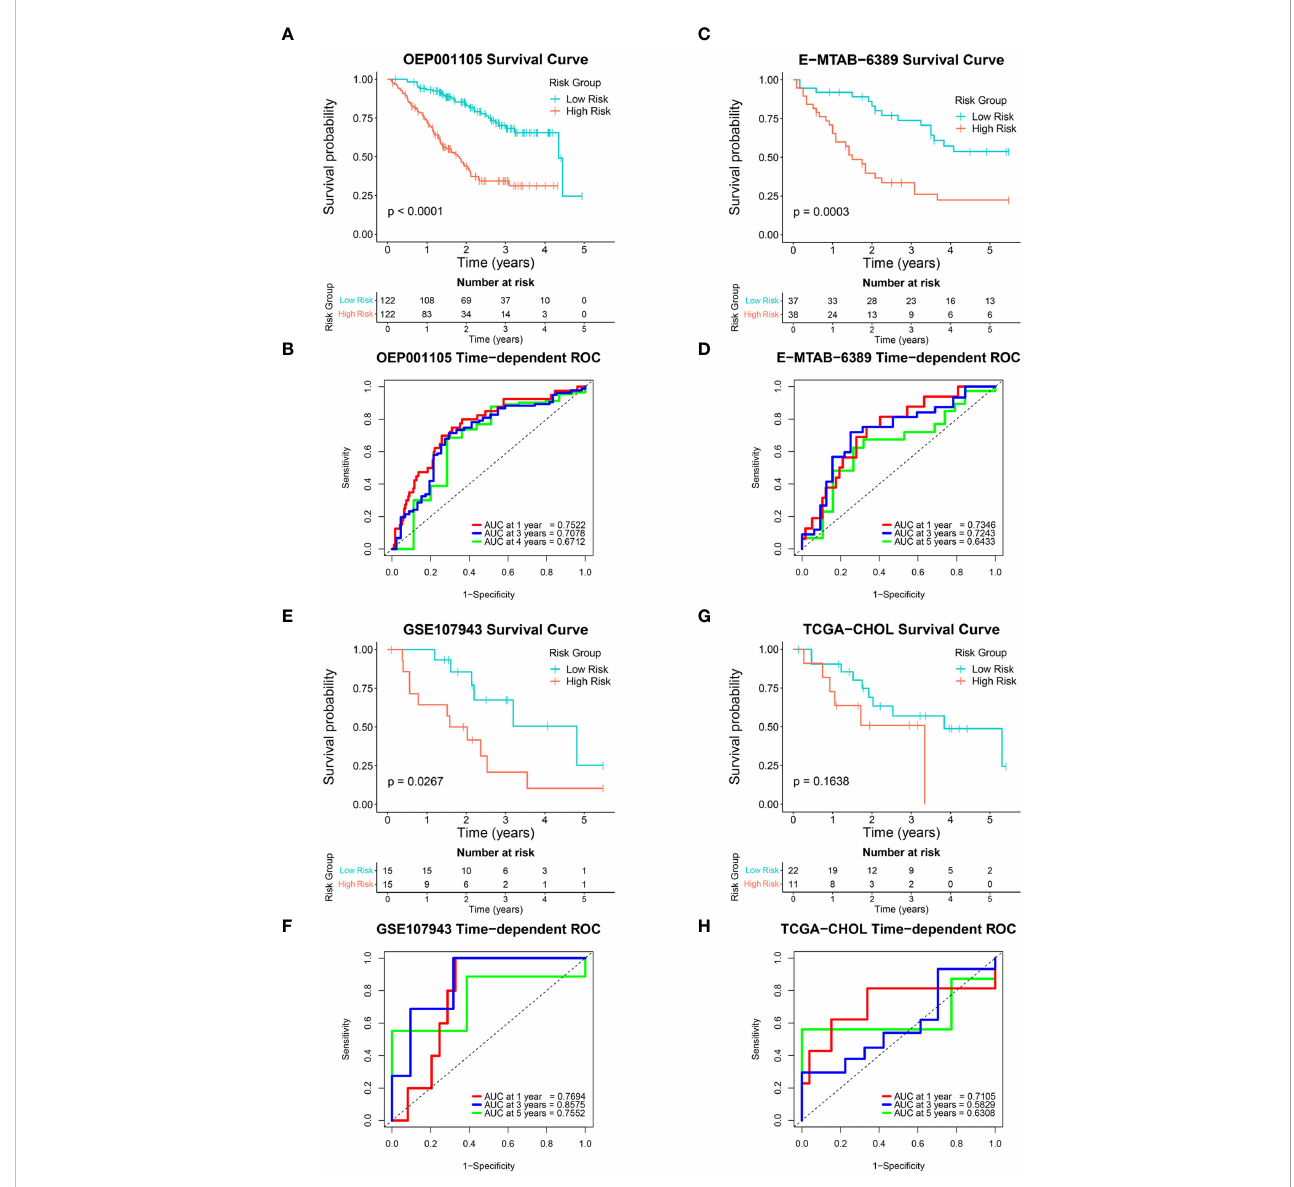
FIGURE 4 Validation of the six-FRG signature in four independent cohorts. (A, C, E, G) Kaplan-Meier curves and (B, D, F, H) time-dependent ROC curves for each independent